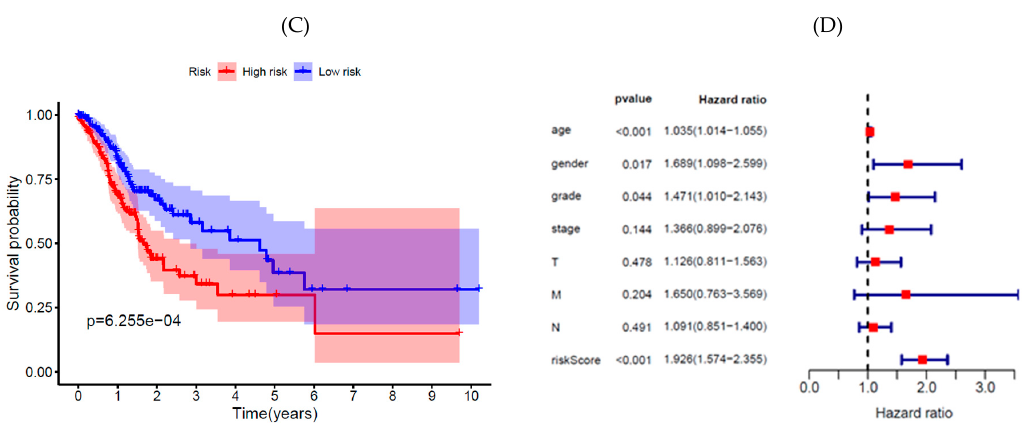
Figure 7. ( A ) Heatmap of methylation levels of samples based on five prognosis genes; ( B ) heatmap of risk Score based on five prognosis genes; ( C ) survival curves; ( D ) hazard ratio.